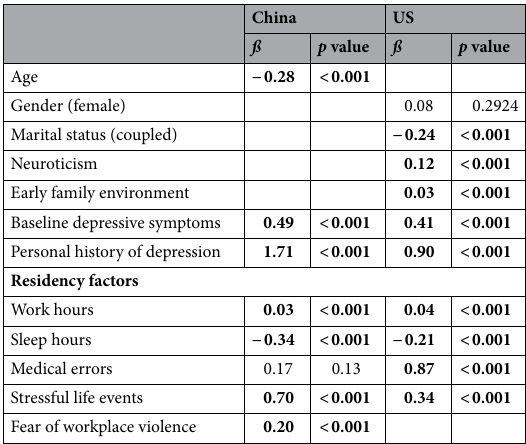
Table 3. GEE model of significant baseline and within residency predictors in China and the US. Empty space: these factors were not originally significant or not measured. All significant factors in the model are